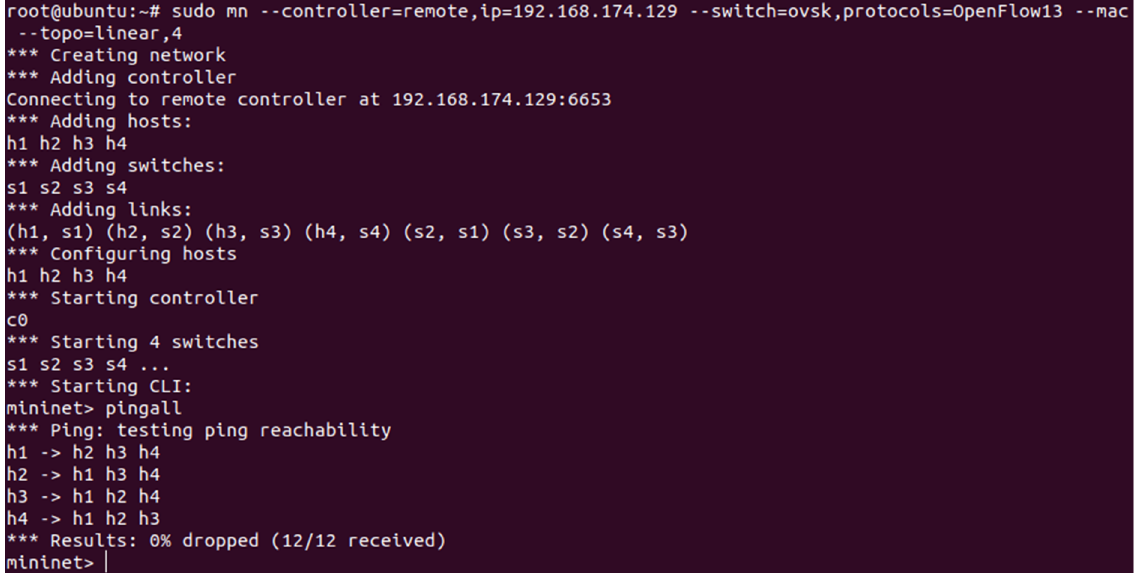
Figure 23. Create custom linear network topology with ODL controller.